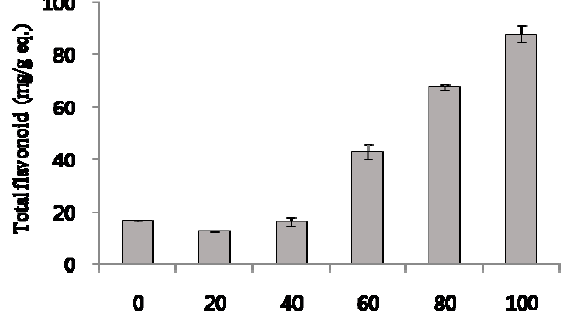
Figure 4. Total flavonoid content of ethanolic extract from C. tricuspidata leaves; 0–100 on x -axis: 0–100% ethanolic extract. Each value was the mean ± SD ( n = 3).